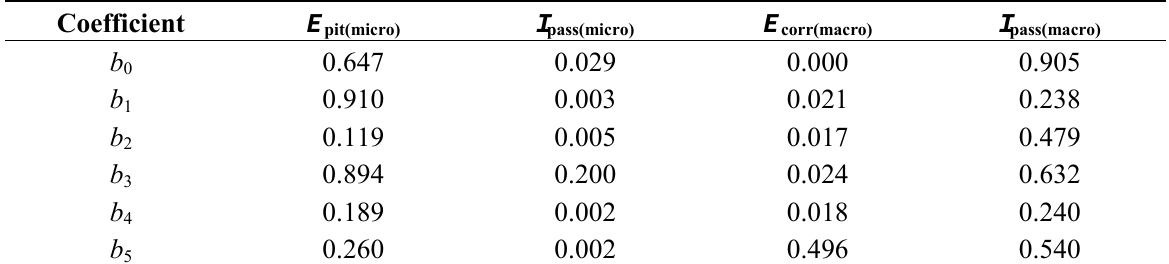
Table 2. p -values for each